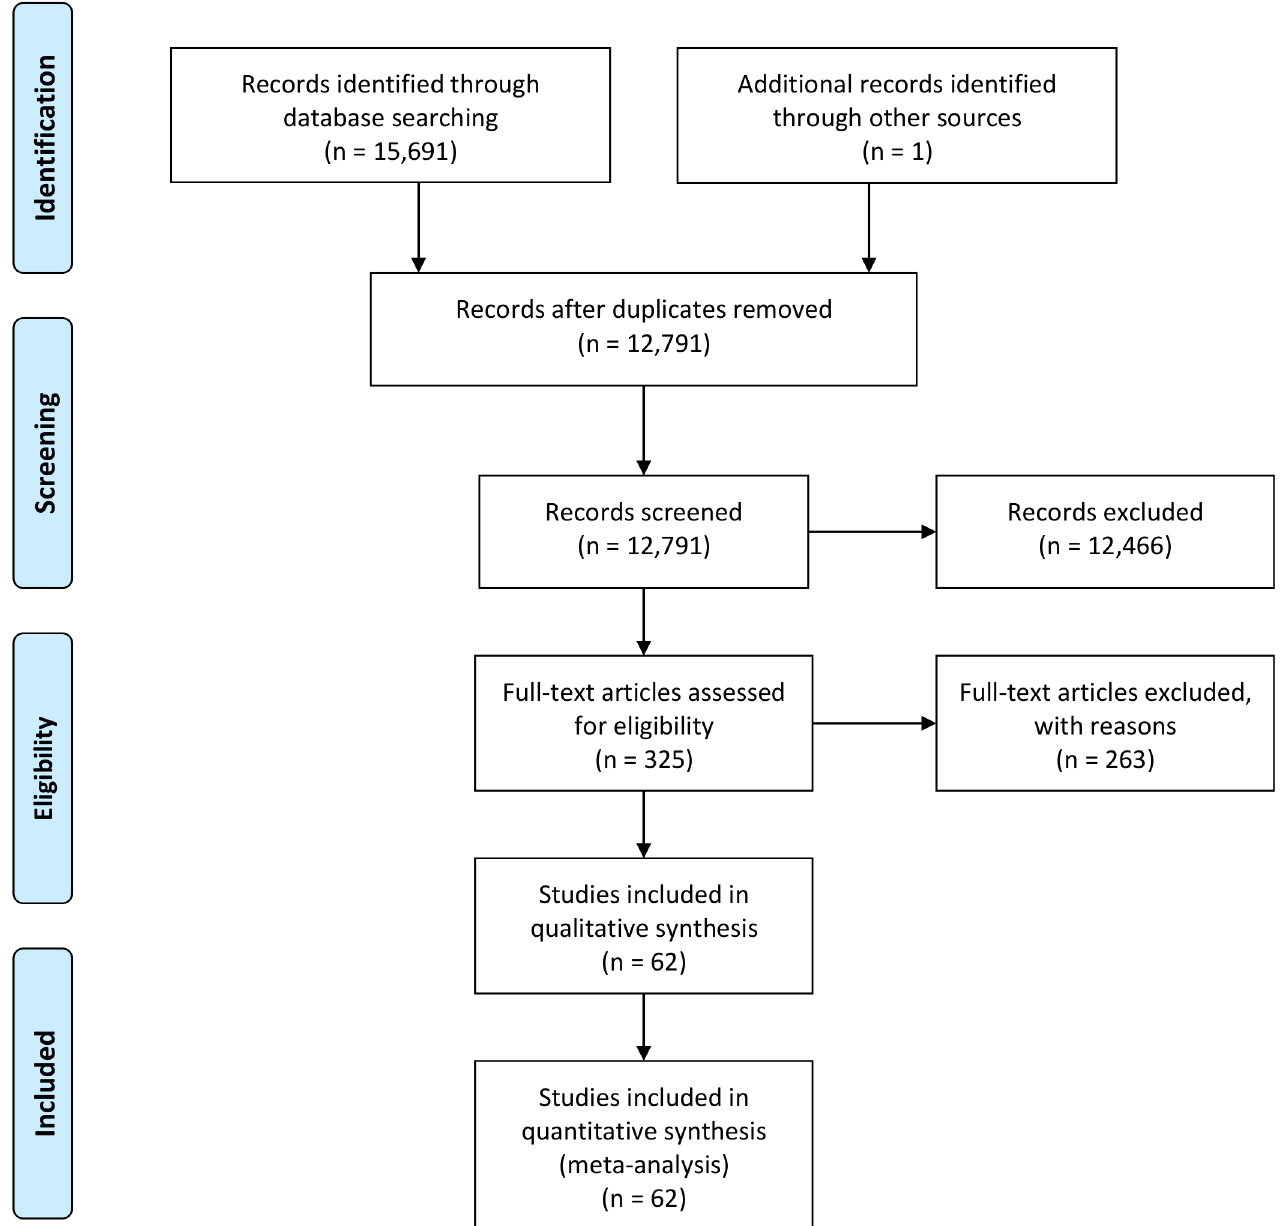
Fig 1. PRISMA flow chart for studies included in the